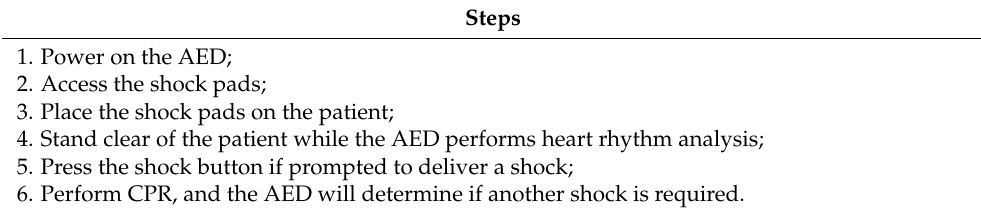
Table 1. Common steps for interacting with an